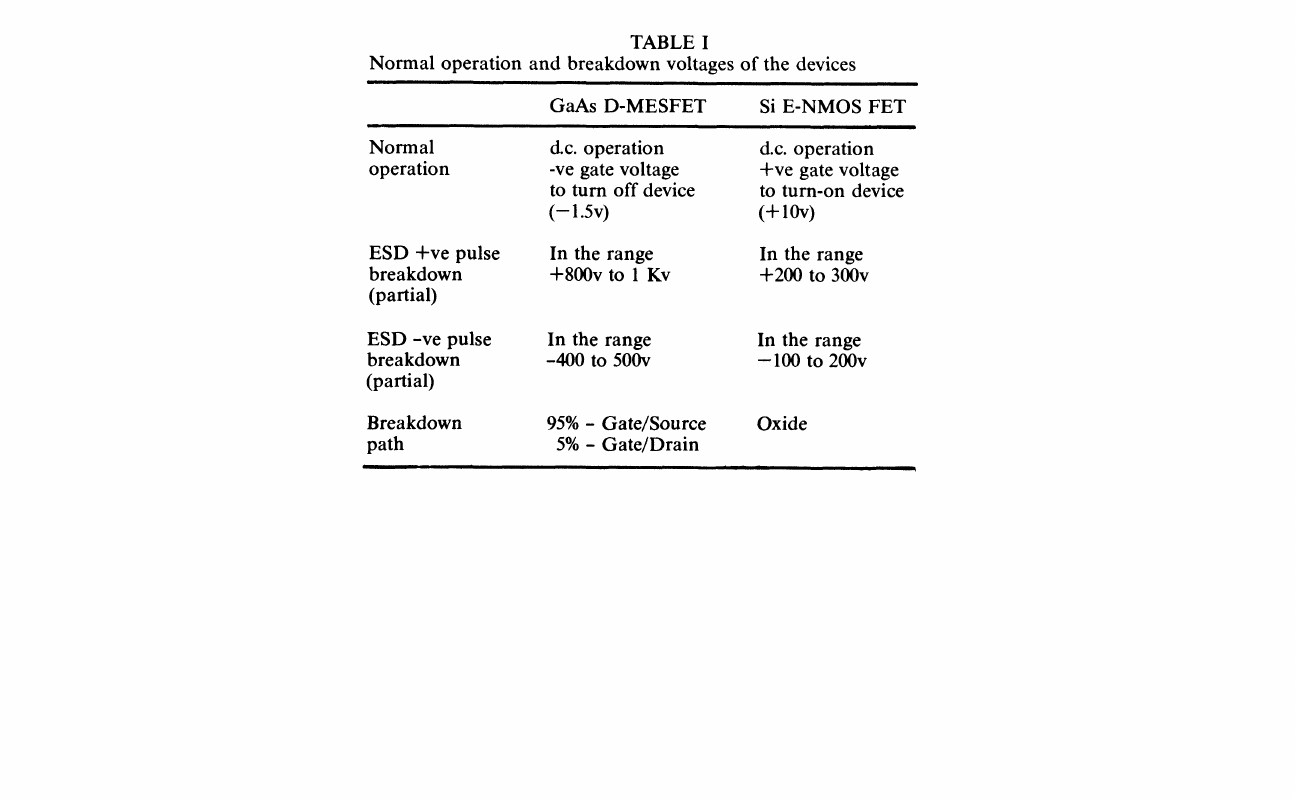
TABLE Normal operation and breakdown voltages of the